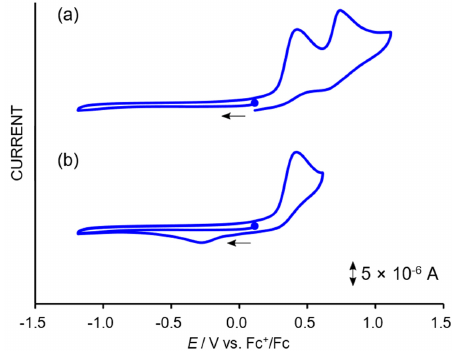
Figure 8. Cyclic voltammograms of [MnBr(CO) 3 (dpc)] in CH 3 CN (glassy carbon WE): ( a ) the whole